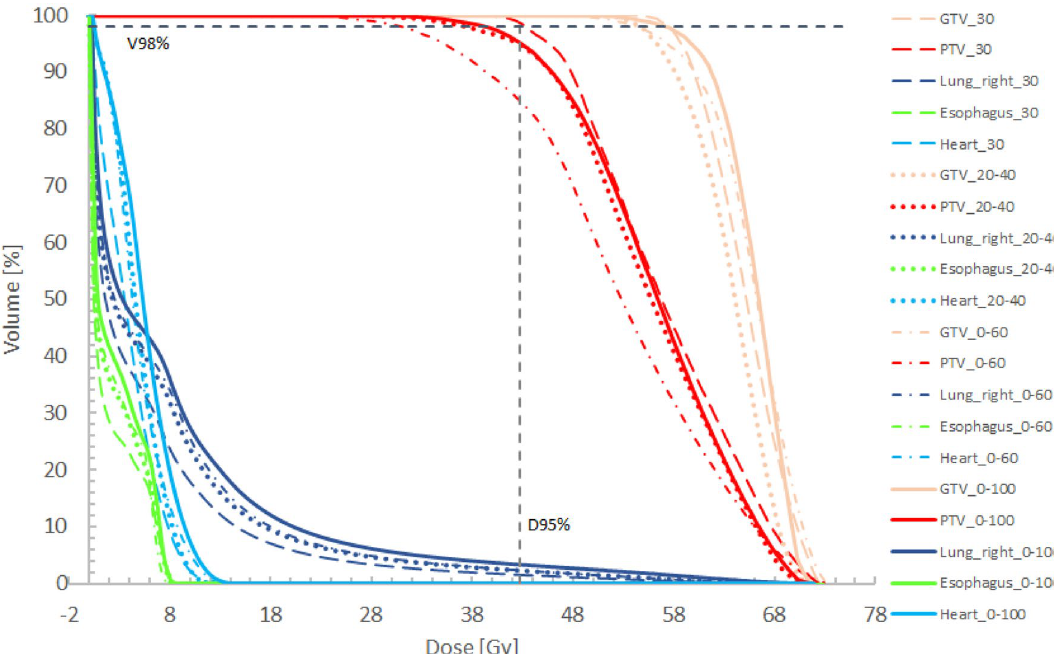
Figure 6. DVHs for patient case 4 for gating windows including phase 30 (dashed), phases 20–40 (dots), phases 0–60 (dashed-dots), and all phases (0–100) (bold solid) included within the gating window. A dashed vertical line showing 95% of the prescription dose as well as a dashed horizontal line indication 98% of the PTV are